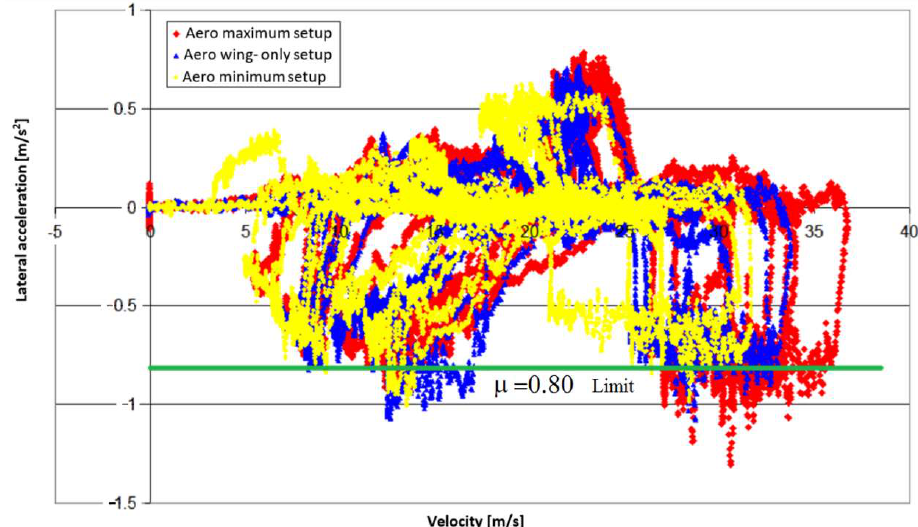
Figure 36. Relationship between lateral accelerations and the travel speed for configurations without aerodynamic and fully active aerodynamics (green line tire friction coefficient = 0.8 limit).